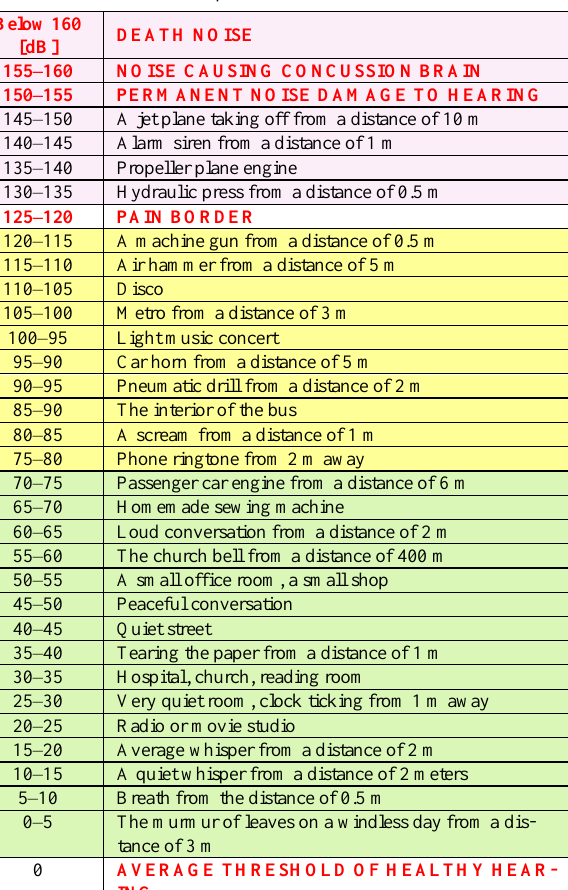
Table 1. The sound pressure levels of various sources sound [dB] and their impact on human health